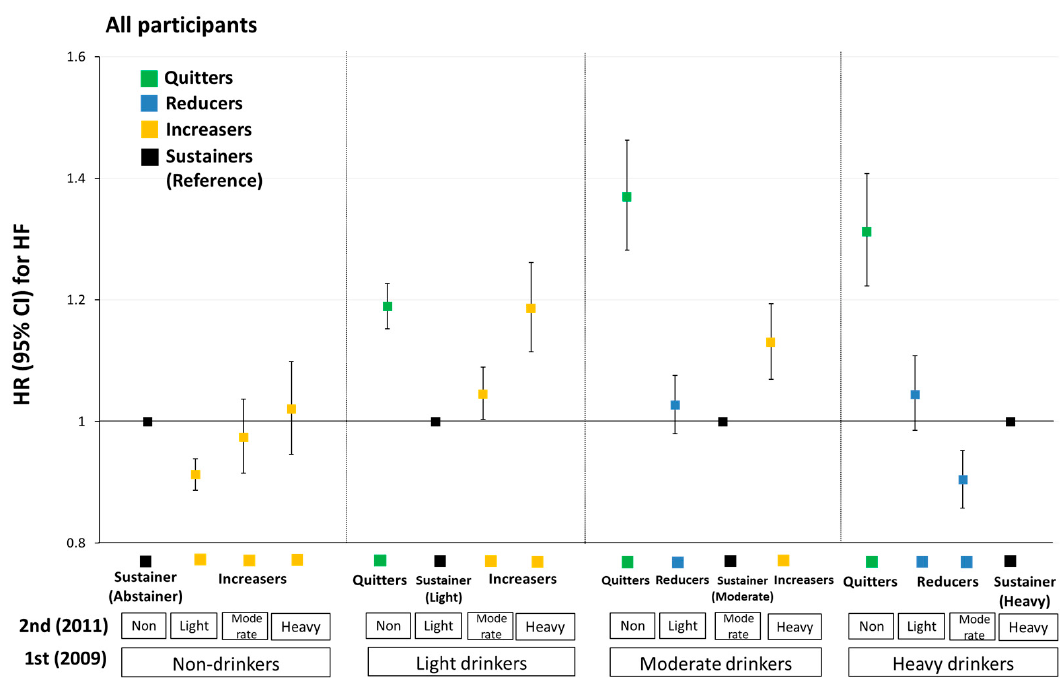
Figure 2. Hazard ratios (HRs) and 95% confidence intervals (CIs) for the association between change in alcohol consumption amount and risk of congestive heart failure. All HRs were adjusted for age, sex, BMI, smoking status, physical activity, area of residence, income, hypertension, dia- betes mellitus, dyslipidemia, systolic blood pressure, fasting glucose level, total cholesterol level, and serum creatinine